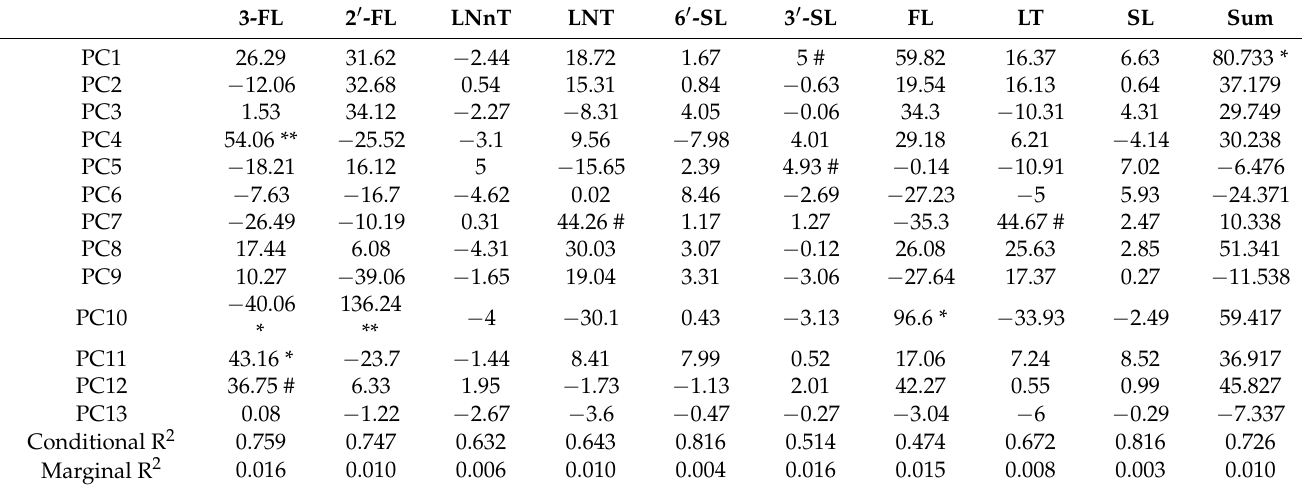
Table 5. The linear mixed-effects analysis of diet principal components for HMOs (beta